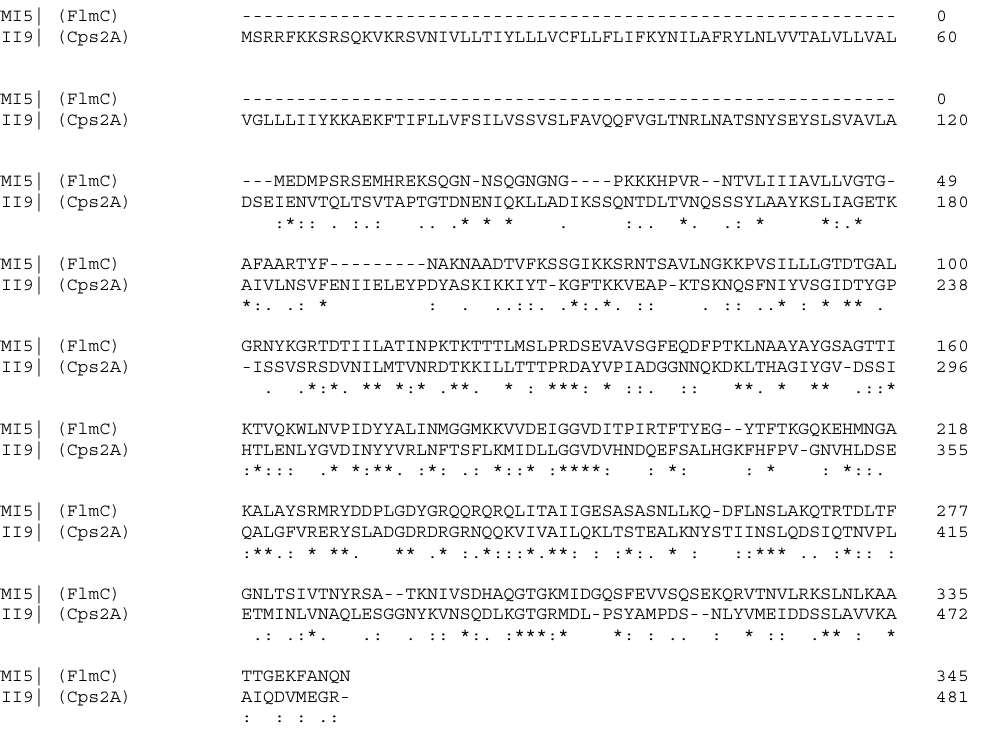
Figure 1. The primary sequence of L. plantarum FlmC aligned with the protein Cps2A from S. pneumoniae .